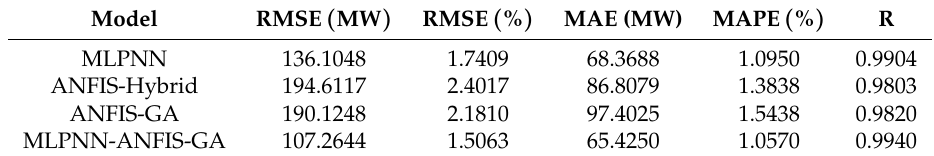
Table 4. Error indicators for MLPNN, ANFIS-Hybrid, ANFIS-GA, and MLPNN-ANFIS-GA models using the selected input vector by